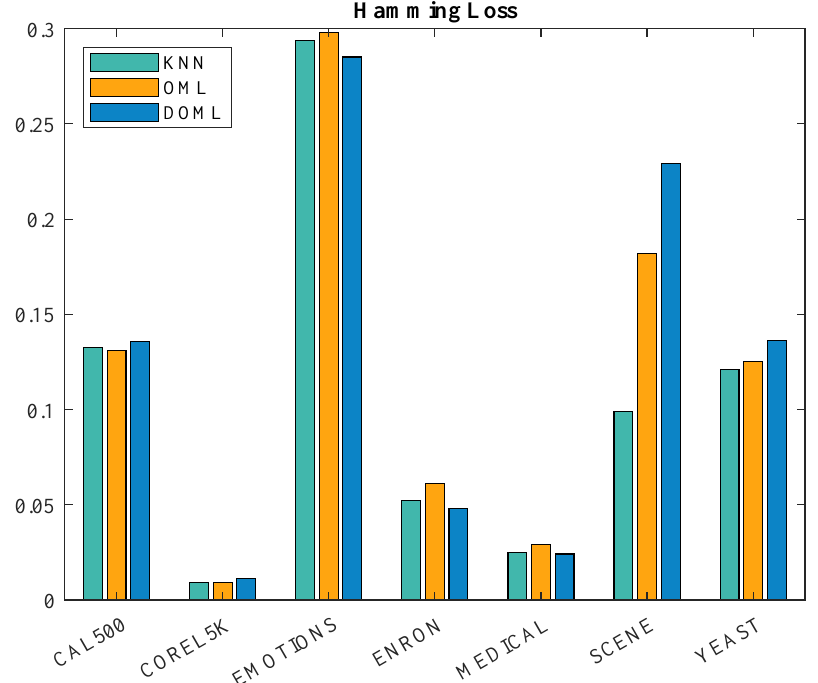
Figure 3. Hamming loss of different algorithms with full benchmark datasets.